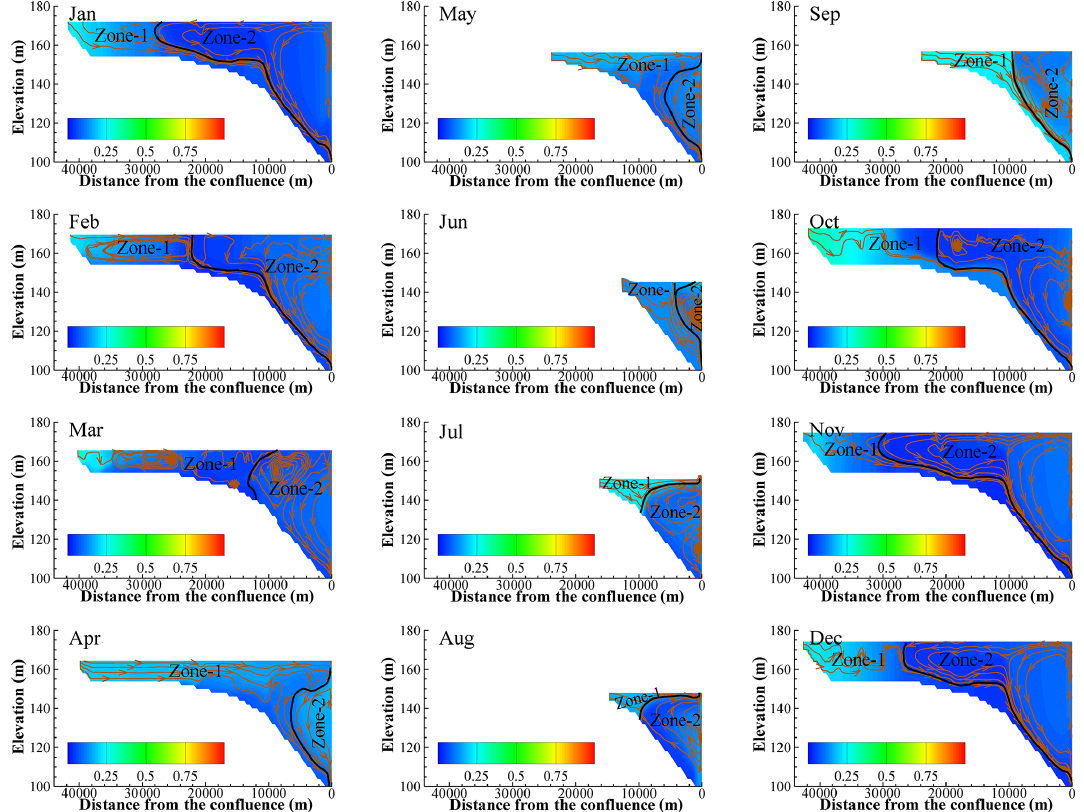
Figure 12. Distribution of NH 3 -N in each month. The black curve in the figure is the boundary between zone 1 and zone 2. The brown curves with arrows are